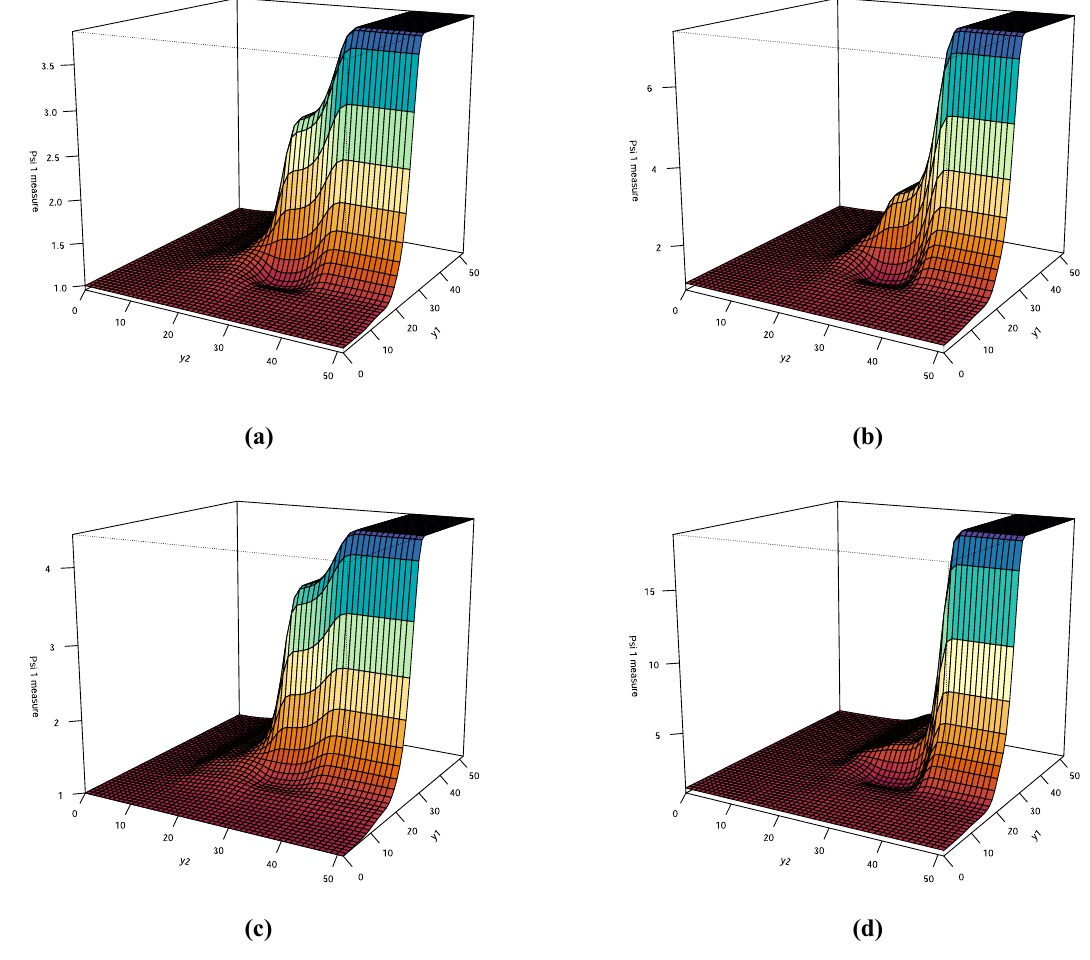
( ) y y Ψ , 1 1 2 for the four couples. ( a ) Couple 1, ( b ) Couple 2, ( c ) Couple 3, and ( d ) Couple